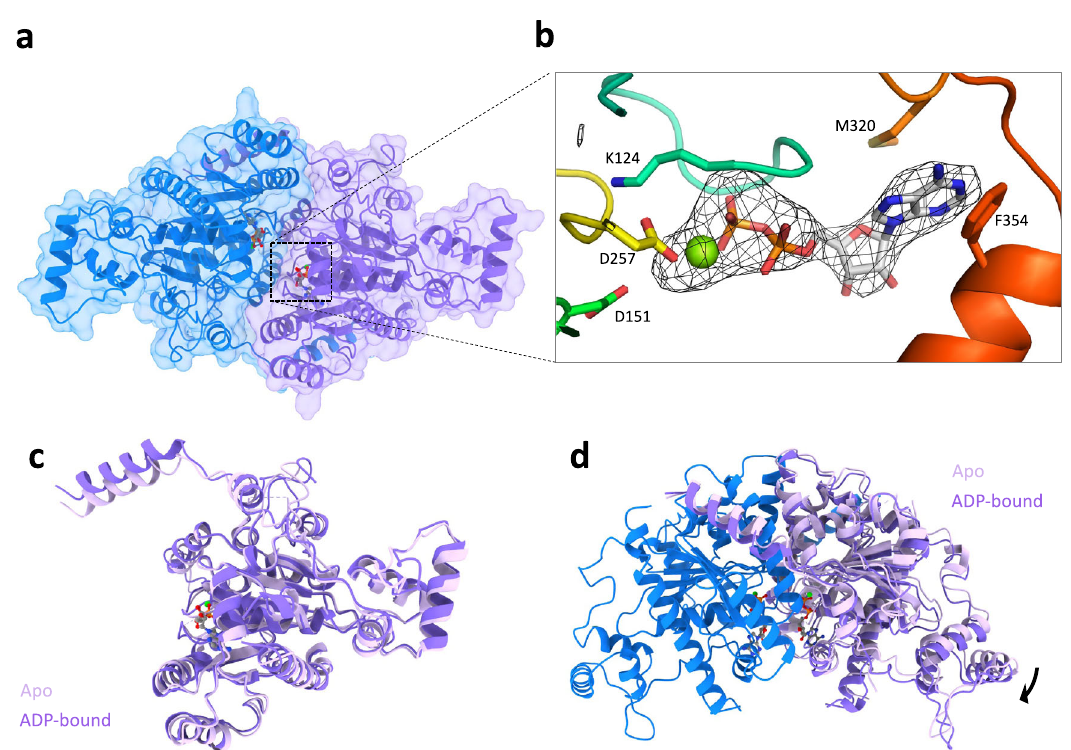
Fig. 2 Structure of ParA2 vc bound to ADP. a Surface representation of the crystal structure of a ParA2 vc -ADP dimer, coloured as in Fig. 1c. The ADP and Mg molecules, present in each ParA2 vc molecules are shown in sticks and sphere representations, respectively. b Close-up view of the ADP and Mg in one of the ParA2 molecules. The composite omit map is shown around the nucleotide. Residues that interact with the nucleotide and Mg are shown in sticks. c , d Overlay of the ParA2vc structure in the apo state (light pink) and ADP-bound state (dark pink). A monomer of each structure is shown in c , and the dimer is shown in d , overlaid on the blue subunit; only one chain of the apo structure is shown for